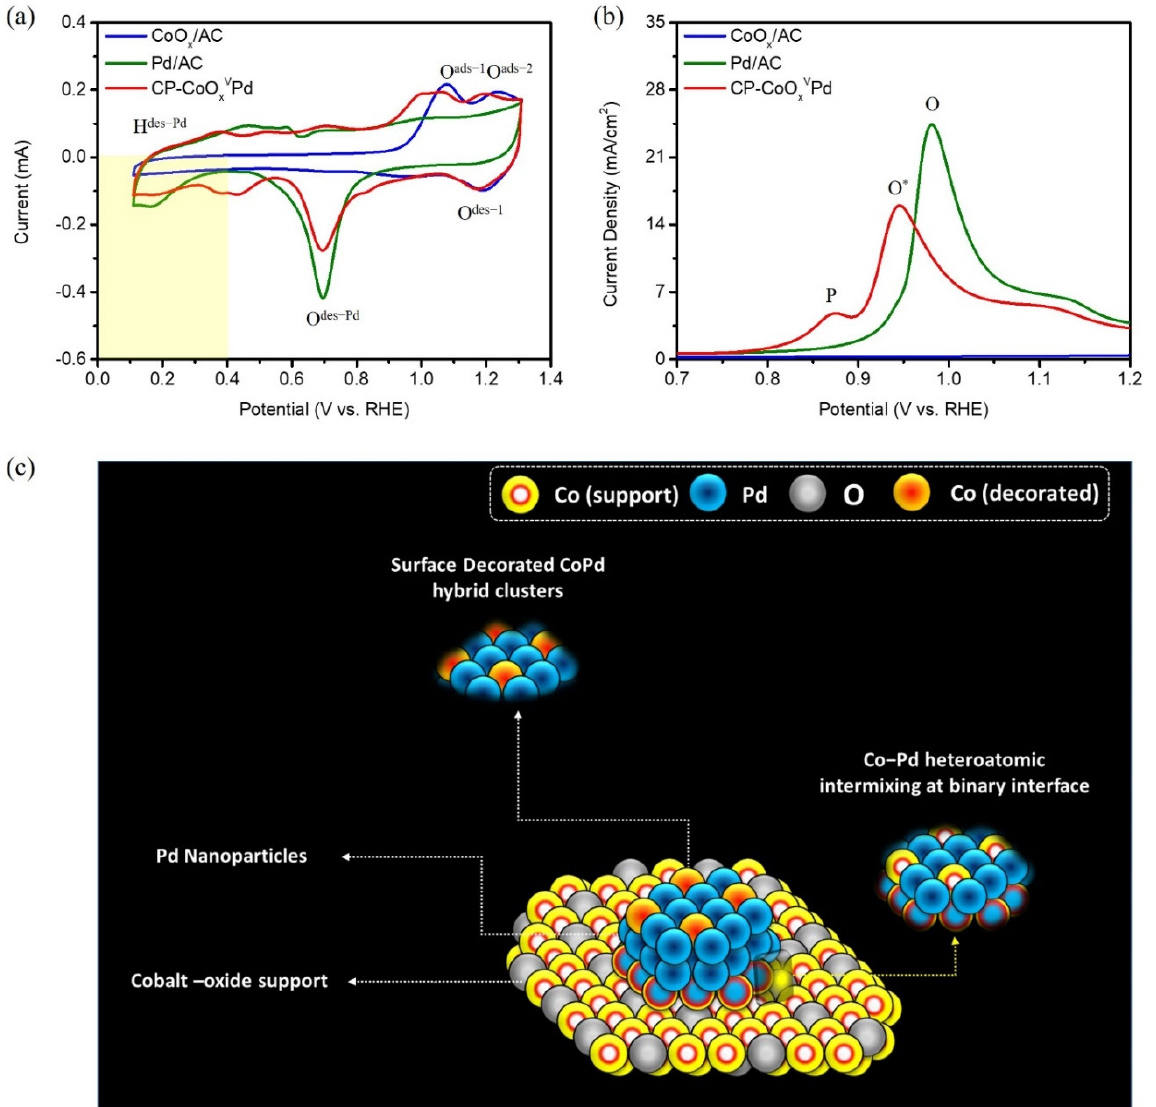
Figure 5. ( a ) CV ( b ) CO-stripping curves CP-CoO xV Pd NC compared with reference samples. ( c ) The schematic representation of the proposed geometric configuration of CP-CoO xV Pd NC.